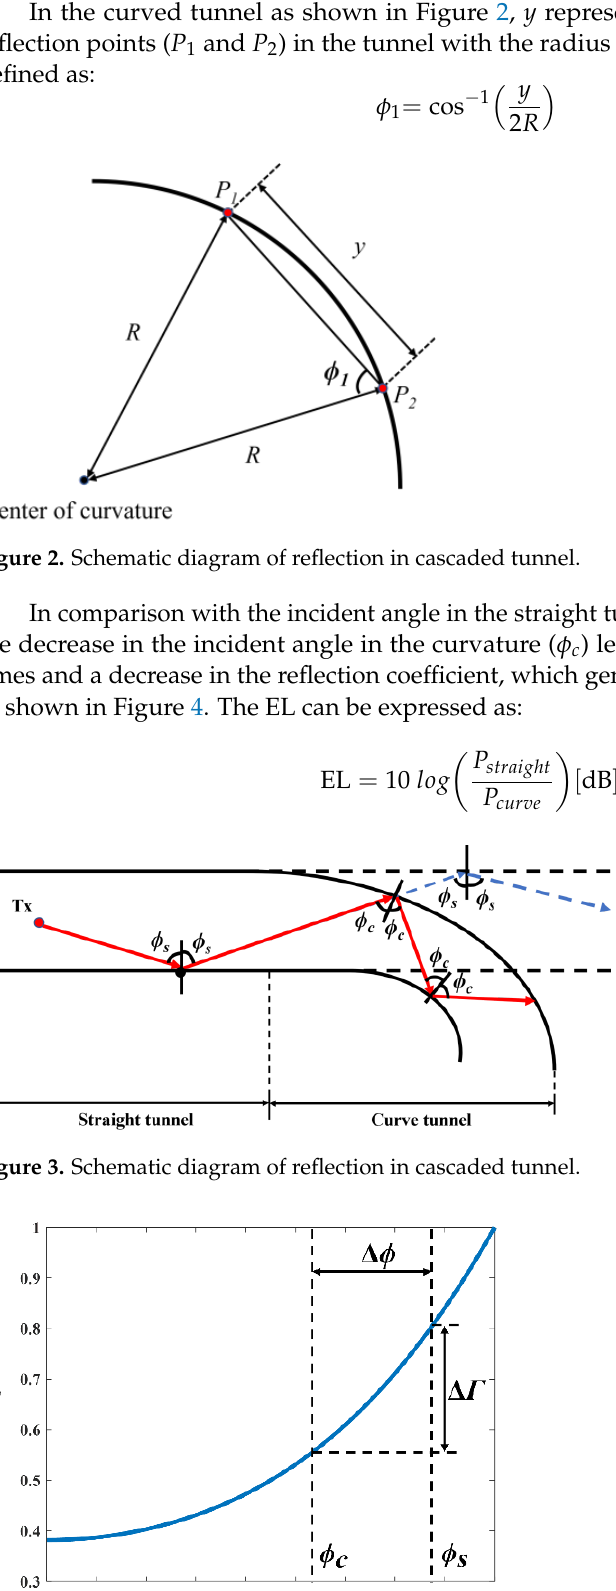
Figure 4. The relationship between incident angle and reflection coefficient.